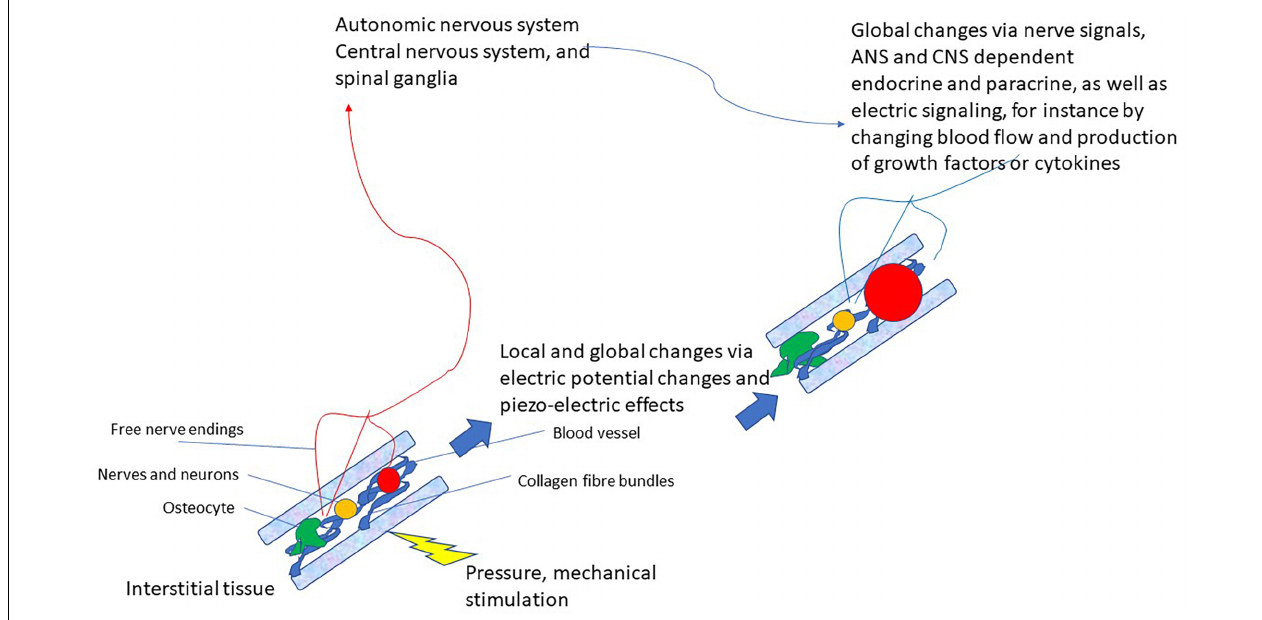
FIGURE 2 | Schematic drawing of the vegetative receptor – vascular reflex (VRVR): mechanical pressure or stimulation is taken up by the mechanosensitive network of collagen fibers, cell-membranes, osteocytes and mechanoreceptors, relayed by local electric currents within the interstitium and by free nerve endings to the ANS/CNS. Thus, global and local changes can be effected that move from local pressure or stimulation to central integration and back to localized changes in the tissue. Also local feedback between nervous tissue (neurons, axons, and ganglia) is possible by this pathway, as they are also embedded in the